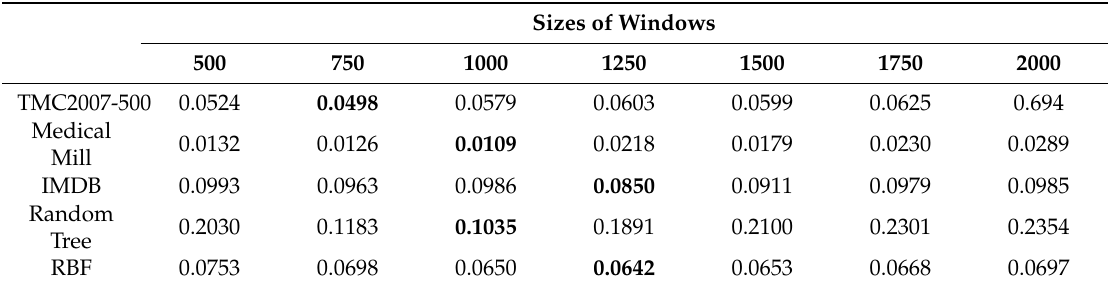
Table 2. Hamming loss using different sizes of windows.